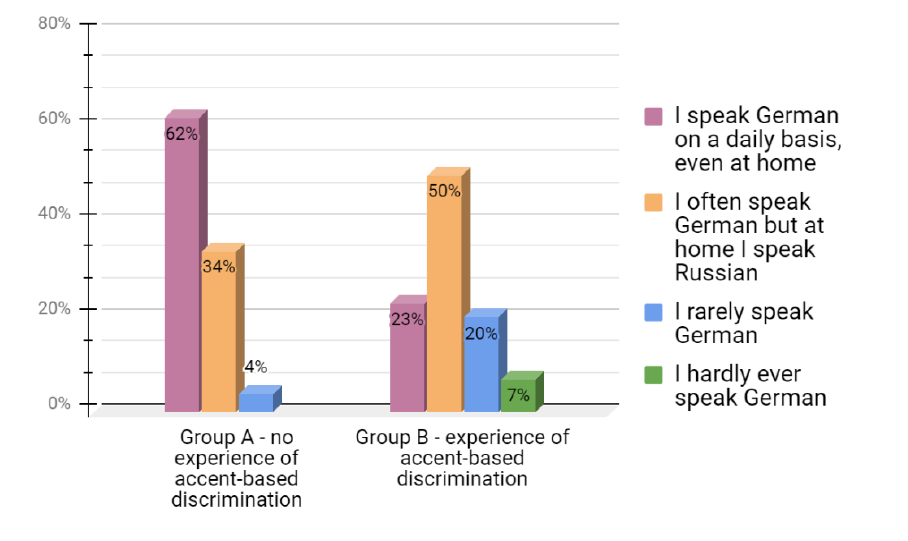
Fig. 3 — Comparative characteristic of German use frequency